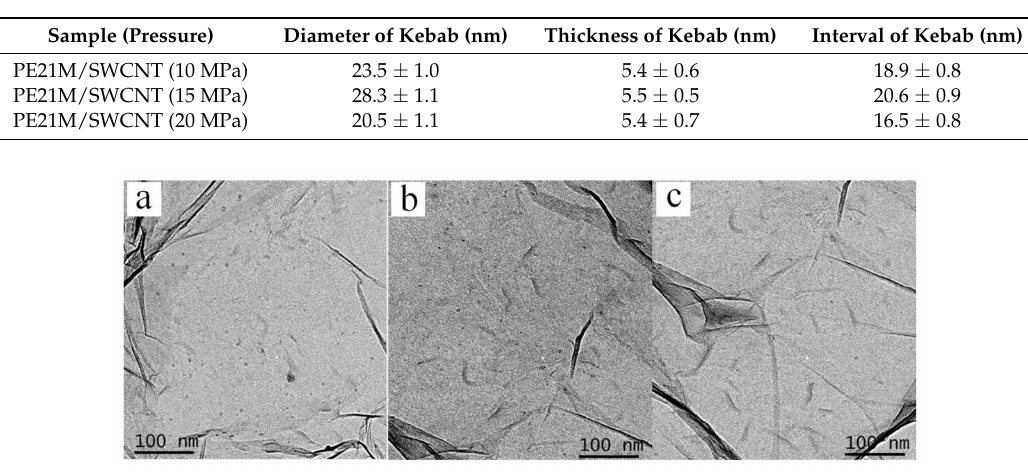
Table 4. The average size of PE21M lamellae formed on SWCNT with the assistance of SC CO 2 based on the TEM images of 200 lamellae.